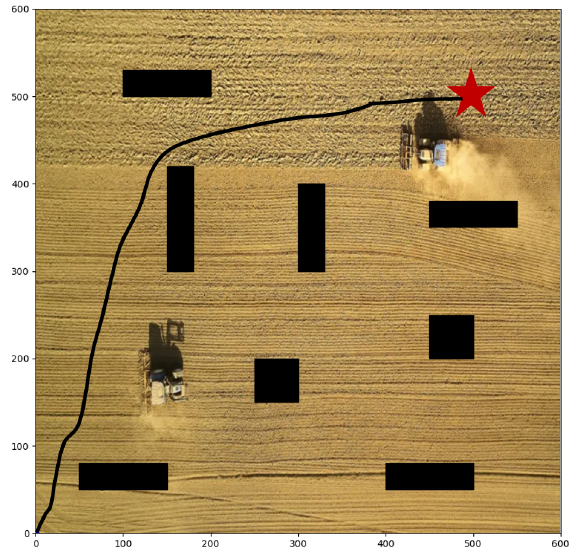
Figure 7. The planned path with start point of (0, 0) and target point of (500, 500).